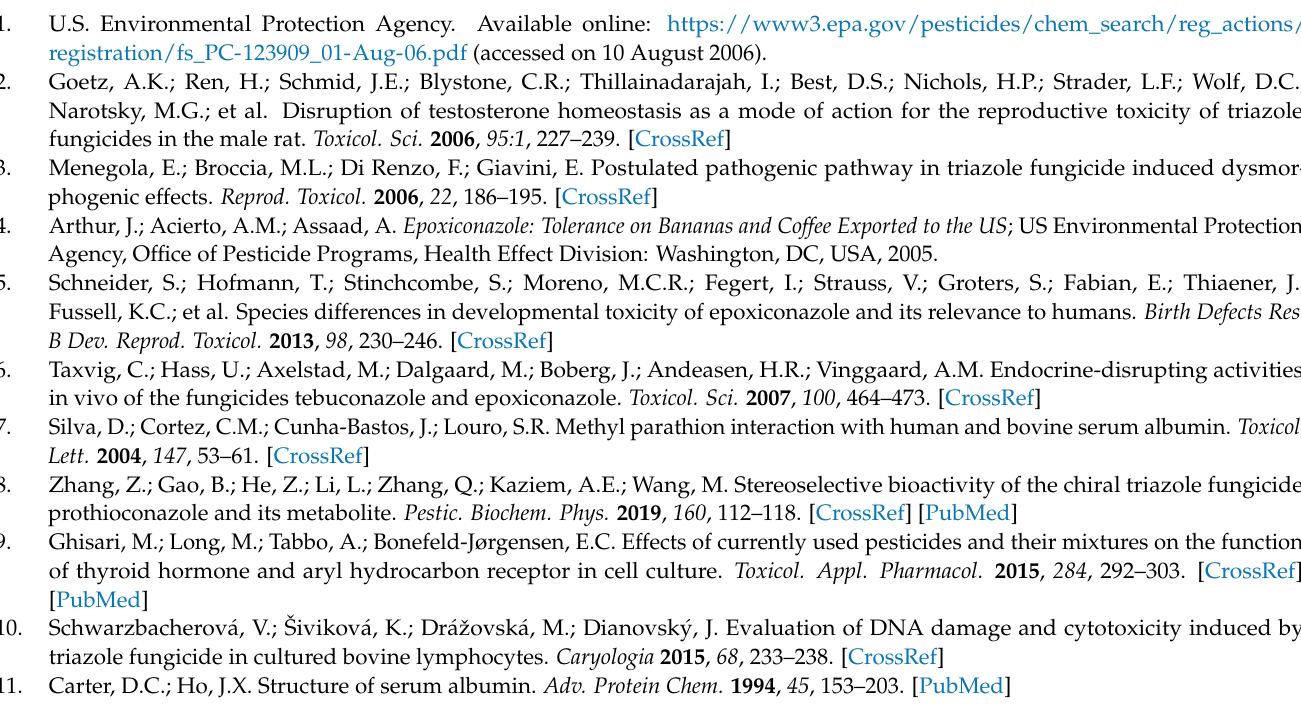
after binding PTC, Figure S4: Hill plot for EPX/HSA interaction, Figure S5: Hill plot for EPX/BSA interaction, Figure S6: Hill plot for PTC/HSA interaction, Figure S7: UV/VIS absorption spectra of BSA in the presence of EPX and PTC, Figure S8: The synchronous spectra of Tyr and Trp of HSA in the presence of EPX, Figure S9: The synchronous spectra of Tyr and Trp of BSA in the presence of EPX, Figure S10: The synchronous spectra of Tyr and Trp of HSA in the presence of PTC, Figure S11: Intensities of fluorescence ratio of EPX/HSA complex in the presence of KPF and IBF markers, Figure S12: Intensities of fluorescence ratio of EPX/BSA complex in the presence of KPF and IBF markers, Figure S13: Intensities of fluorescence ratio of PTC/HSA complex in the presence of KPF and IBF markers, Figure S14: 3D fluorescence spectra of HSA and EPX/HSA 16/1 complex, Figure S15: 3D fluorescence spectra of BSA and EPX/BSA 16/1 complex, Figure S16: 3D fluorescence spectra of HSA and PTC/HSA 16/1 complex, Figure S17: CD spectra of HSA in presence of EPX, Figure S18: CD spectra of BSA in presence of EPX, Figure S19: CD spectra of HSA in presence of